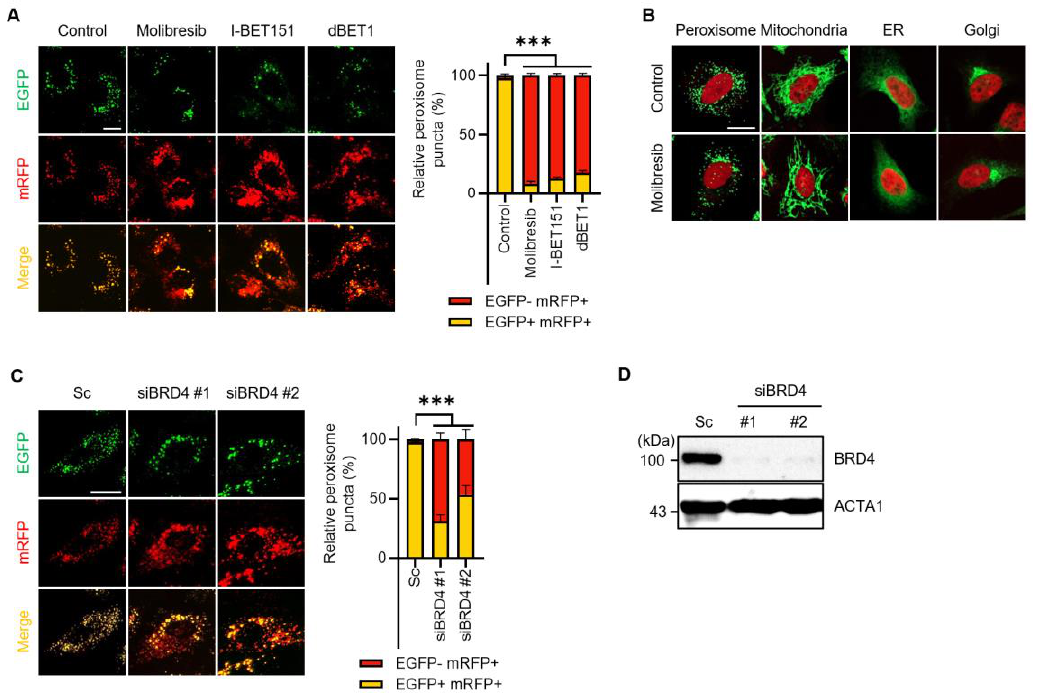
Figure 1. Inhibition of BRD4 promotes pexophagy in RPE cells. ( A ) RPE/mRFP-EGFP-SKL cells were treated with inhibitors of BRD4 [molibresib (10 µM), I-BET151 (10 µM), dBET1 (10 µM)] for 72 h. The cells were fixed for imaging under a fluorescence microscope. The numbers of cell with EGFP(+)- and mRFP(+)-labeled autophagosomes or EGFP(-) and mRFP(+)-labeled autolysosomes, which displayed the peroxisomal reporter mRFP-EGFP-SKL due to lysosomal delivery, were counted and are presented as percentages; ( B ) HeLa cells stably expressing pmTurquiose2-Peroxi, pmTurquiose2-Mito, pmTurquiose2-ER, or pmTurquiose2-Golgi were treated with molibresib (10 µM) for 72 h and stained with DRAQ (red). Cellular organelles were imaged by confocal microscopy. The scale bar indicates 20 µm; ( C , D ) RPE/mRFP-EGFP-SKL cells were transiently transfected with siRNA targeting BRD4 (siBRD4), and then, EGFP and mRFP fluorescence was imaged and quantified ( C ); reduced expression of BRD4 by siRNA was verified by Western blotting ( D ). (Data indicate means S.E.M. *** p < 0.001).